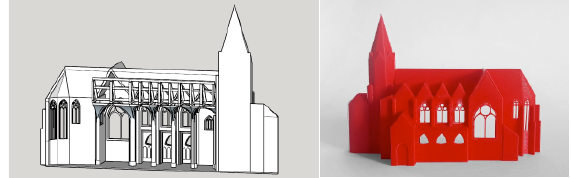
Figure 11 . A subset of the point cloud of the collegiate Sainte Croix church.